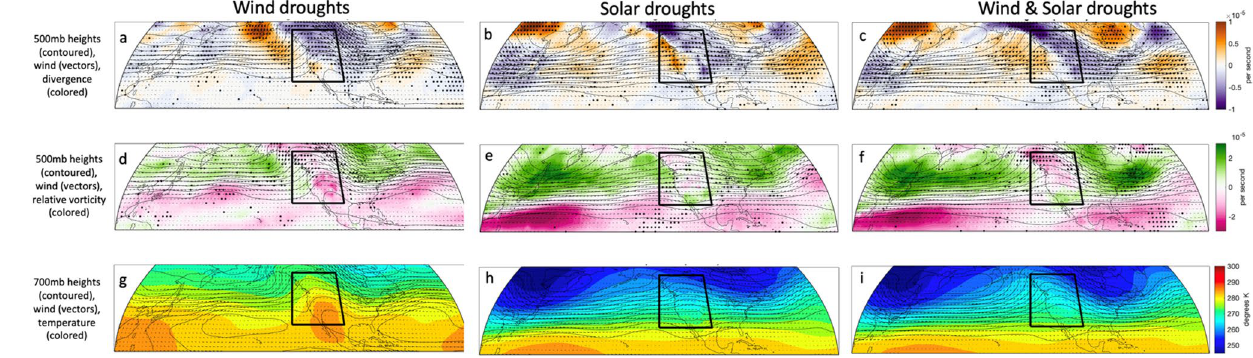
2-year return periods. The variables displayed are described on the left. The stippling shows where at least 28 of the 37 weeks (> 75%) showed values of the same sign. Figures S18 and S21 shows the sensitivity of this plot to defining droughts using either the 0.5th percentile (Fig. S18) or the 2nd percentile (Fig.